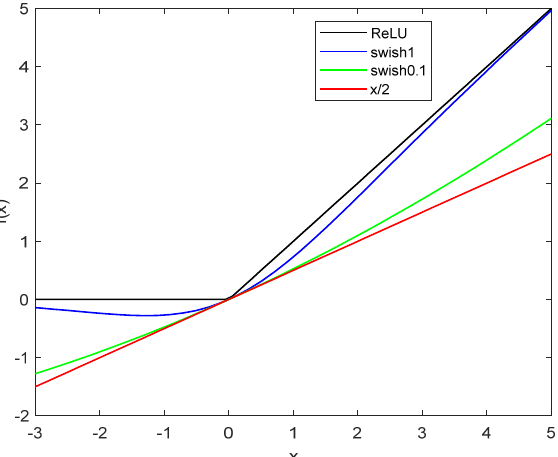
Figure 5. The waveform of CReLU activation function (where CReLU6 represents the ceiling factor c takes 6, and CReLU represents the ceiling factor c takes 10).